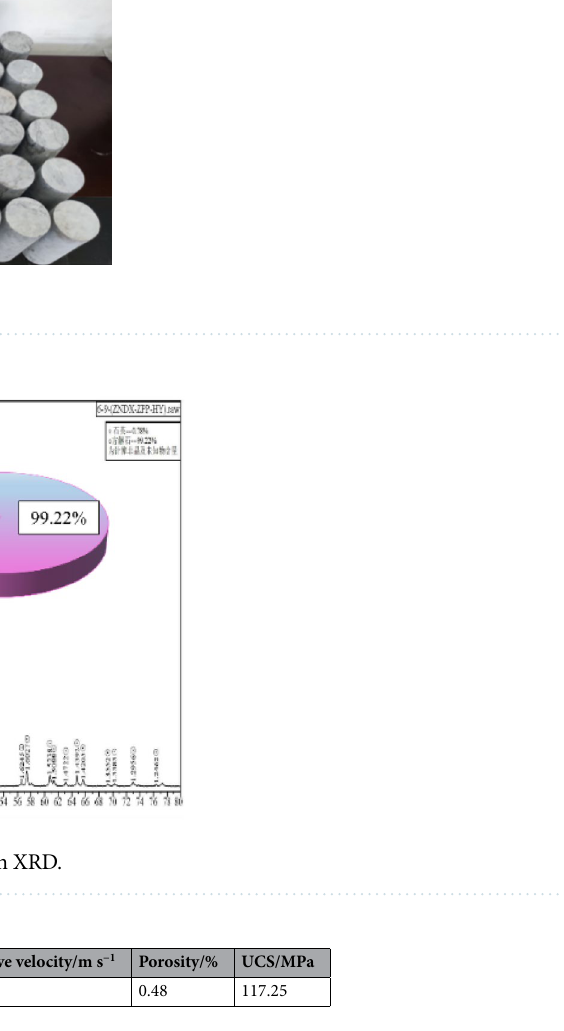
Table 1. Principal physical and mechanical parameters of